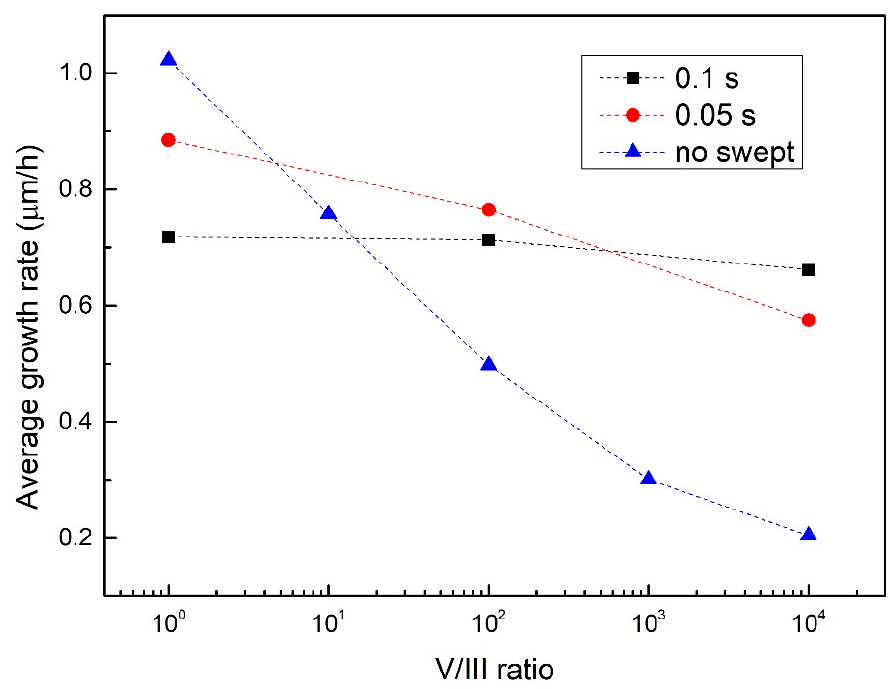
Figure 8. Average growth rate in the second cycle for different purge times and V/III ratios.